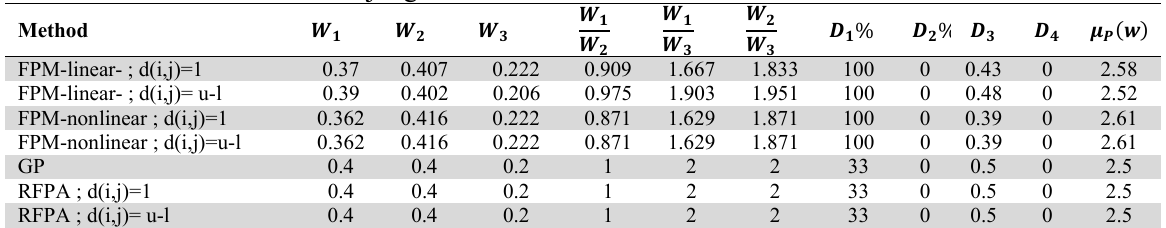
Three-dimensional inconsistent judgments